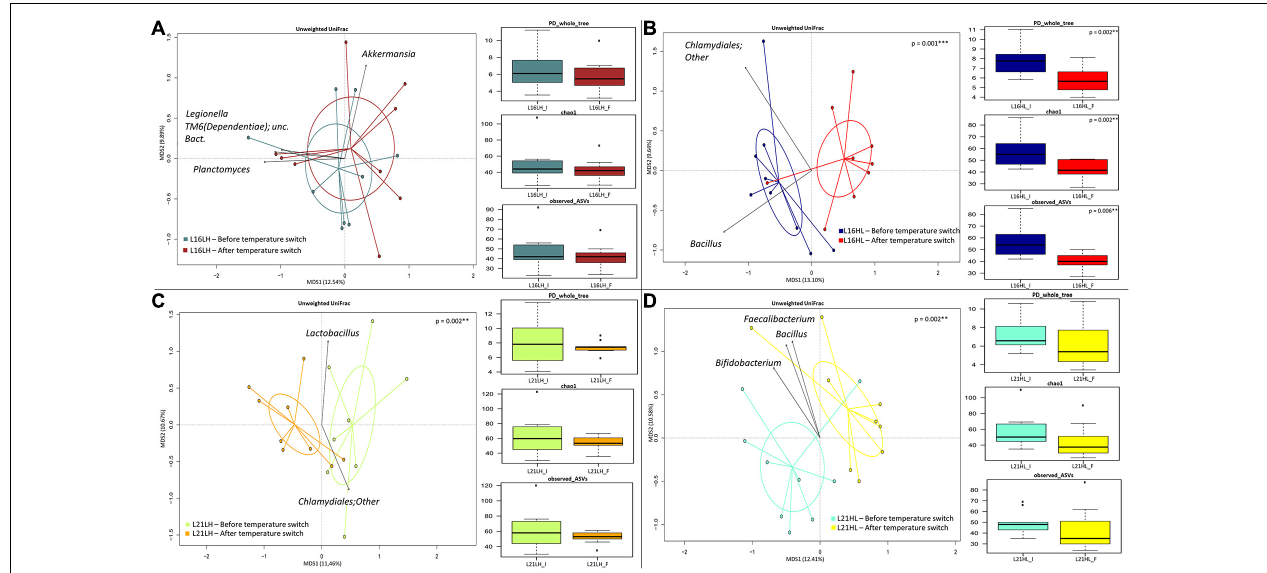
FIGURE 2 | Beta diversity and alpha diversity of gut microbiota of gilthead sea bream fed with the experimental diets and exposed to temperature switch over 121 days. (A,B) PCoA based on unweighted UniFrac distances between gut microbiota structure of animals fed with L16 diet and exposed, respectively, to summer shift (LH transition) and autumn shift (HL transition). Samples are significantly separated, only in the autumn shift condition (permutation test with pseudo-F ratios Adonis; p = 0.001). (C,D) PCoA based on unweighted UniFrac distances between gut microbiota structure of animals fed with L21 diet and exposed, respectively, to summer shift (LH transition) and autumn shift (HL transition). Samples are significantly separated in both conditions (permutation test with pseudo-F ratios Adonis; p = 0.002, p = 0.002). Black arrows are obtained by fitting the genus relative abundance values for each sample within the ordination space (function envfit of the vegan R package, with a p -value < 0.01). In each panel, boxplots show alpha diversity values, measured by Faith’s Phylogenetic Diversity (PD_whole_tree), Chao1 index, and amplicon sequence variants (observed_ASVs). Only for the HL group (B) , all metrics showed a significant reduction (Kruskal–Wallis test p < 0.01) of alpha diversity in the final condition of group fed with L16 diet and subjected to a temperature switch toward autumn temperature (HL). L16, low-lipid 16% diet; L21, high-lipid 21% diet; HL, constant temperature exposure to high (H) temperature of 23 ◦ C before, and to low (L) temperature of 17 ◦ C after, temperature switch; LH, constant temperature exposure to low (L) temperature of 17 ◦ C before, and to high (H) temperature of 23 ◦ C after, temperature switch. Temperature switch occurred on day